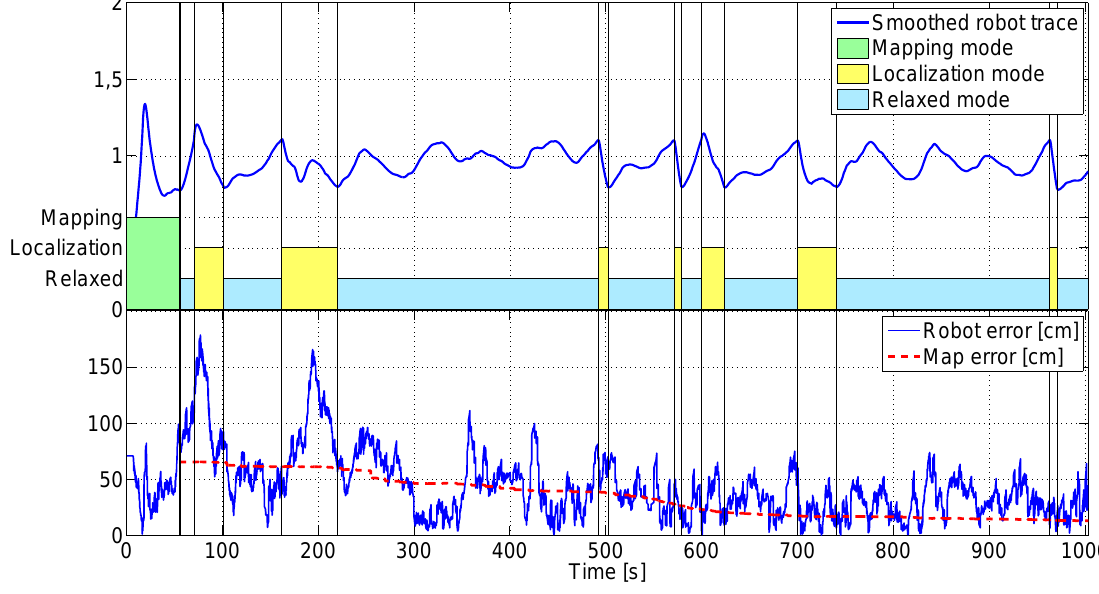
Figure 11. Details of the operation of the proposed scheme along the experiment: ( top ) values of the smoothed robot trace; ( center ) the measurement gathering state; ( bottom ) robot and map location